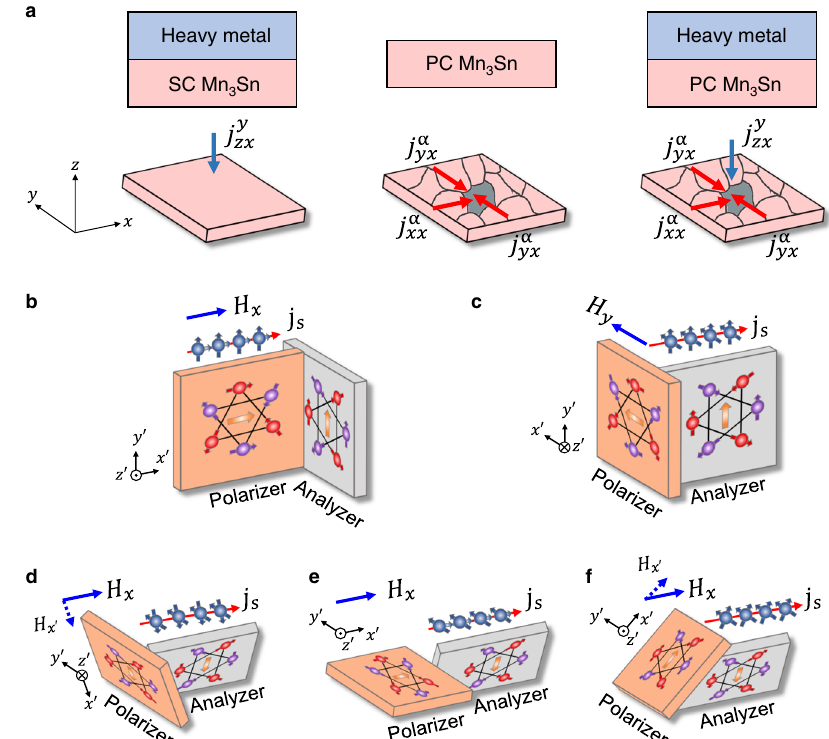
Fig. 5 | Schematics of SOT and IGSTT-based switching. a Three different structures for current-induced switching: heavy metal /single-crystalline (SC) Mn 3 Sn, polycrystalline (PC) Mn 3 Sn, and heavy metal /polycrystalline Mn 3 Sn. b – f Schematic of IGSTT-based switching. The polarizer (left grain) denotes the grain which provides spin-polarized current, whereas the analyzer (right grain)